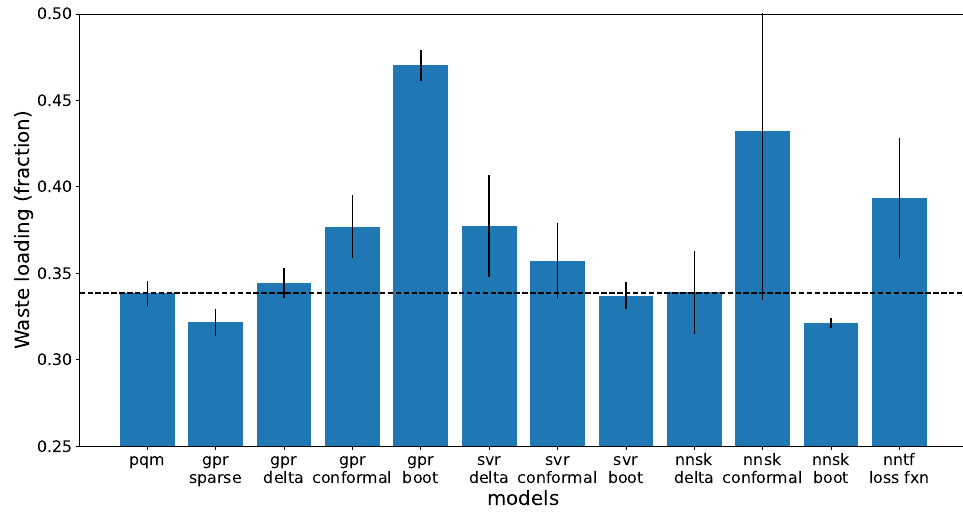
Figure 9. Waste loading in the optimized glass, the objective of the optimization